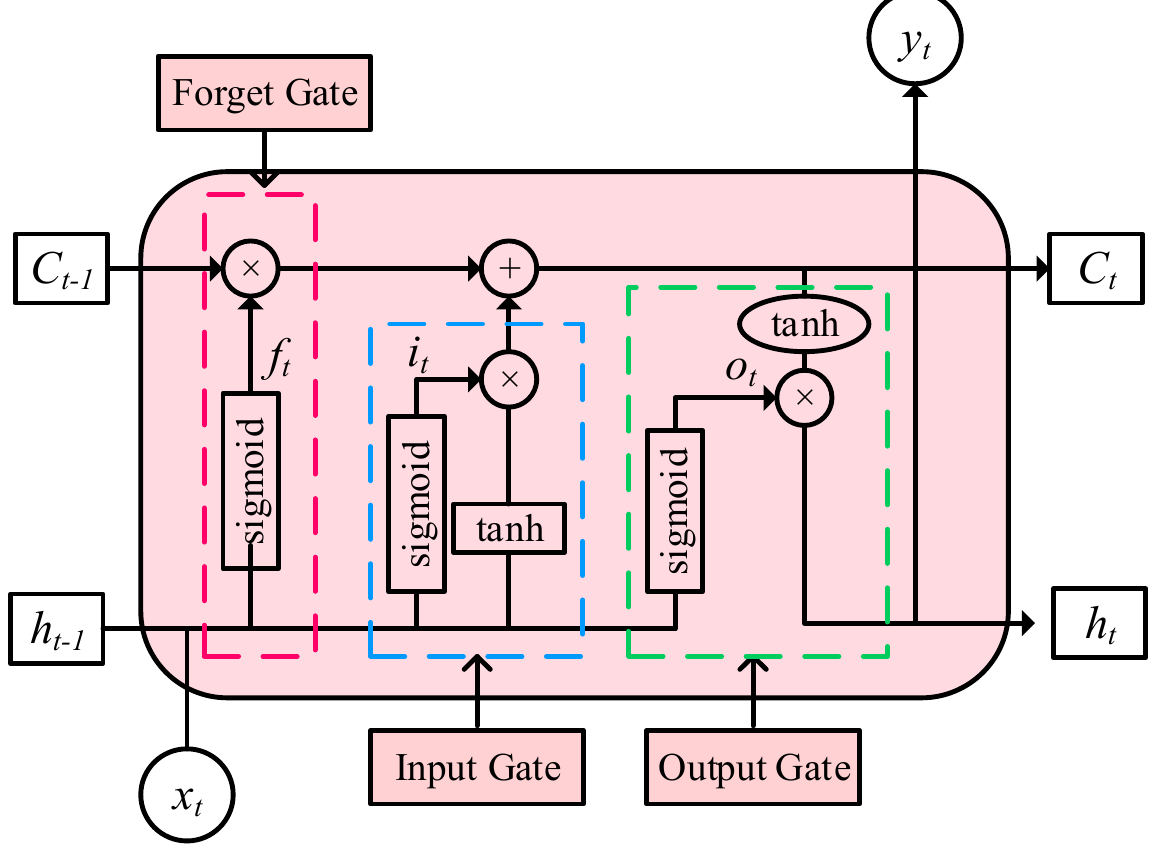
Figure 2. Internal structure of LSTM.